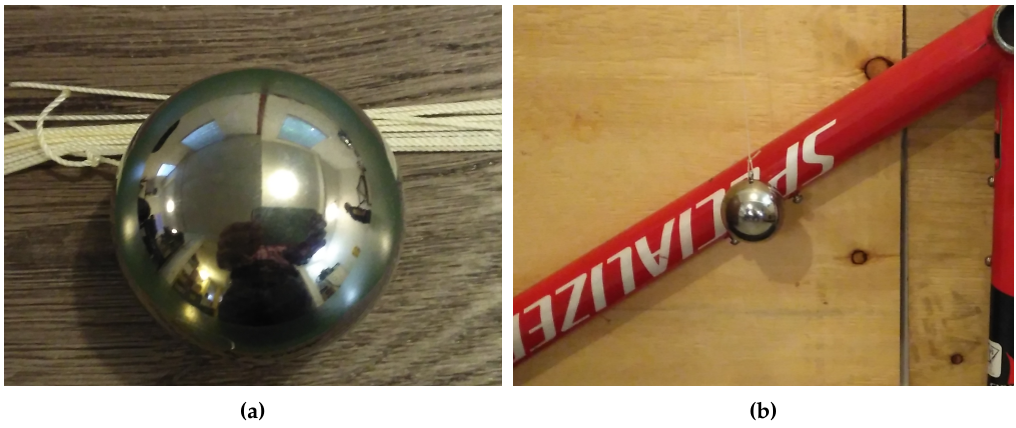
Figure 4. Calibrated steel ball used in the experiments. ( a ) Steel ball and rod. ( b ) Ball hitting a similar bicycle frame to produce impact